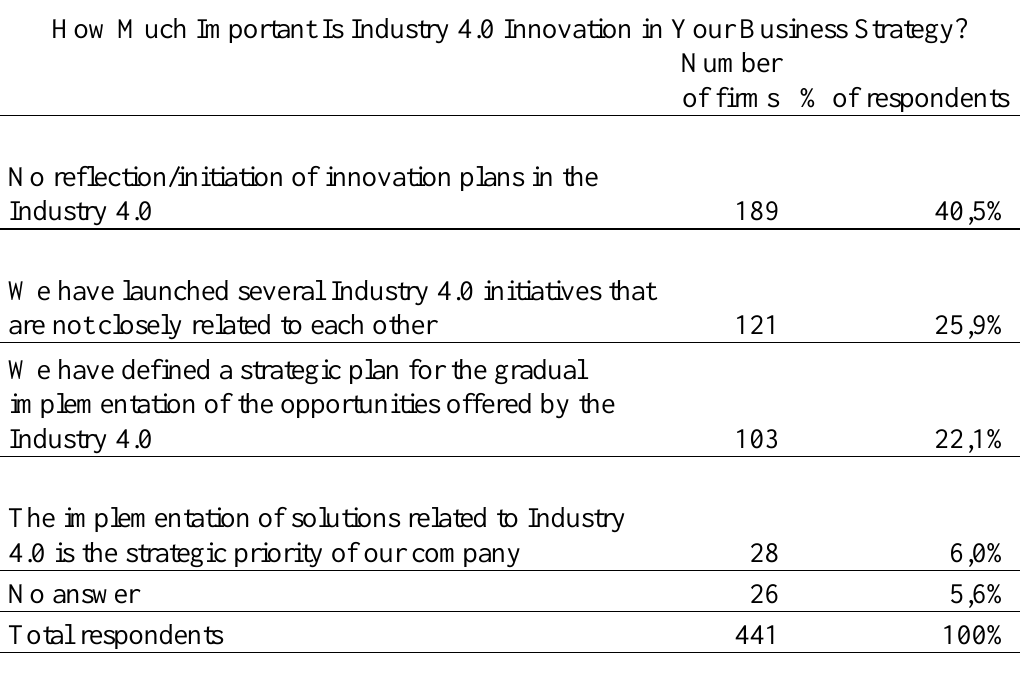
Table 1: The Strategic Importance of Innovation 4.0 in the Automotive